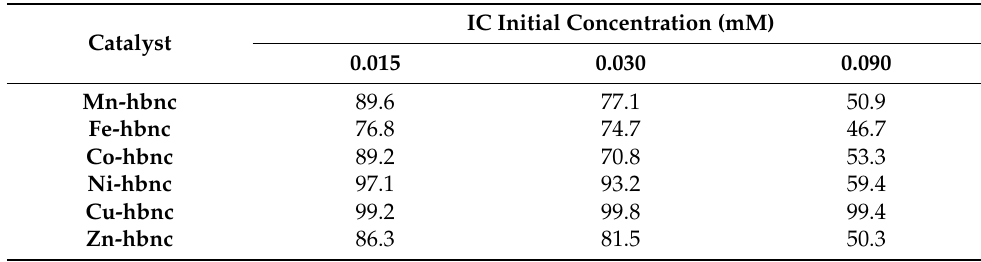
Table 8. Oxidative degradation of IC at different molar ratios of the IC in water (H 2 O 2 /IC = 32.6; catalyst concentration 1 g/L, 150 rpm, 2 h at 25 ◦